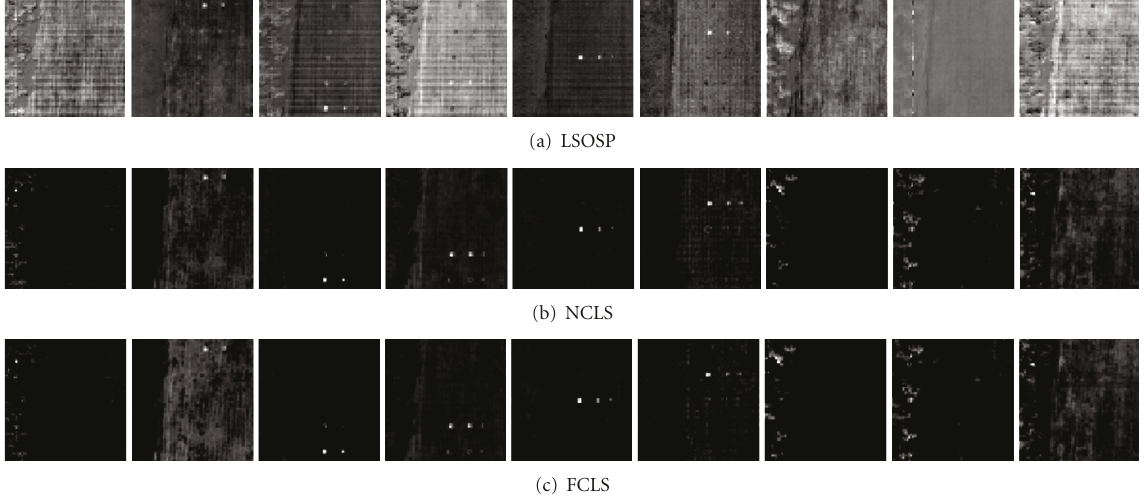
} n VD extracted from j j = 1